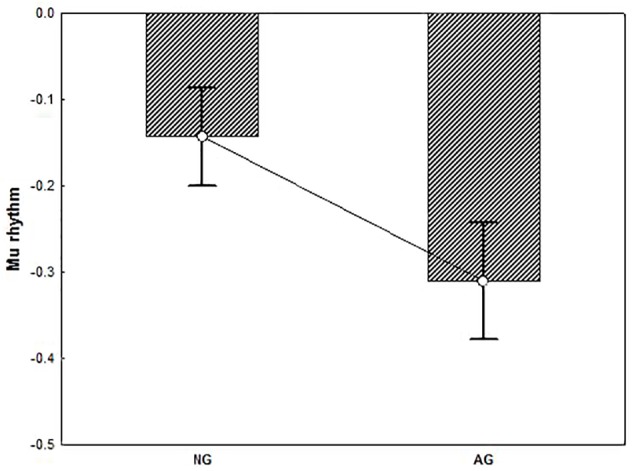
The plot represents the group difference (p < 0.05) for the t-test conducted on the alpha activity (mu rhythm) recorded from the Central electrode pool. Negative values indicate suppression. Result showed that mu rhythm was significantly more suppressed in AG vs. NG. Error bars represent standard error of mean (SE).